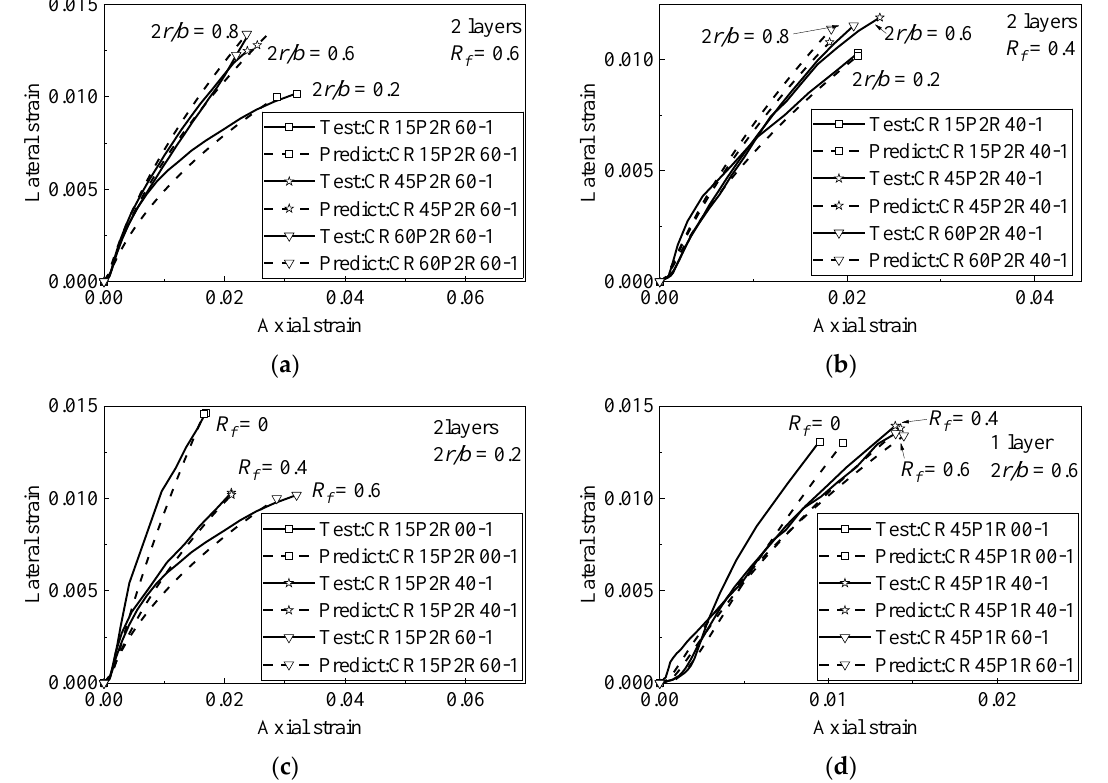
Figure 5. Performance of proposed axial–lateral strain model (data from reference [15]). ( a ) Specimens with different corner radii ( b ) Specimens with different corner radii ( c ) Specimens with different rubber content ( d ) Specimens with different rubber content.